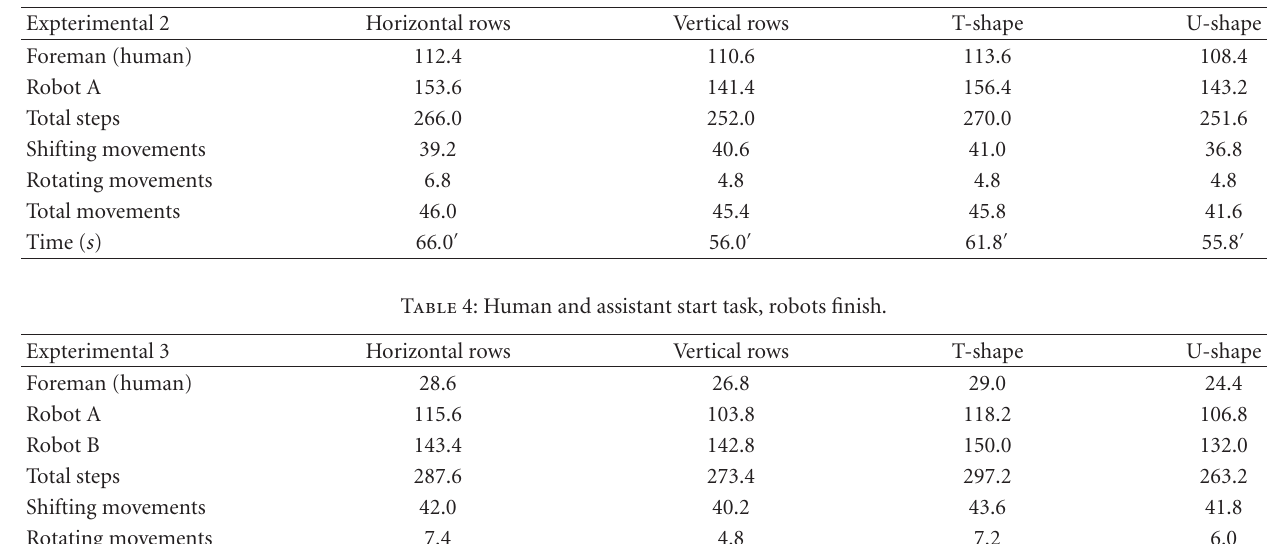
Table 3: One assistant robot helps human throughout.